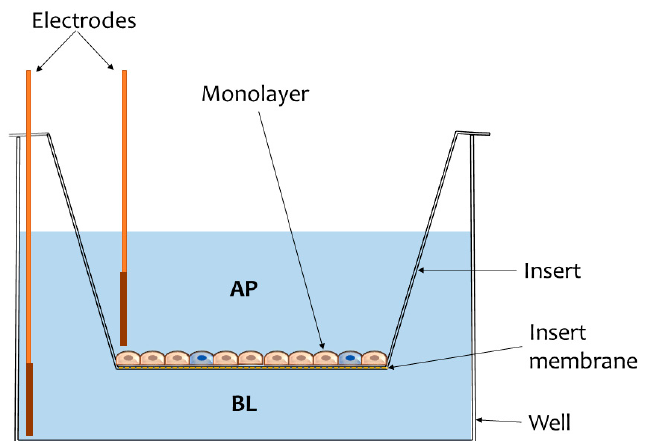
Figure 1. Illustration of a common experimental model used in intestinal transport studies. The cells are cultivated on inserts supplied with semipermeable membranes through which microparticulate diffusion may occur. Monolayer integrity is usually assessed by measuring transepithelial electrical resistance (TEER) using chopstick electrodes inserted in the apical (AP) and basolateral (BL) compartments of the well.